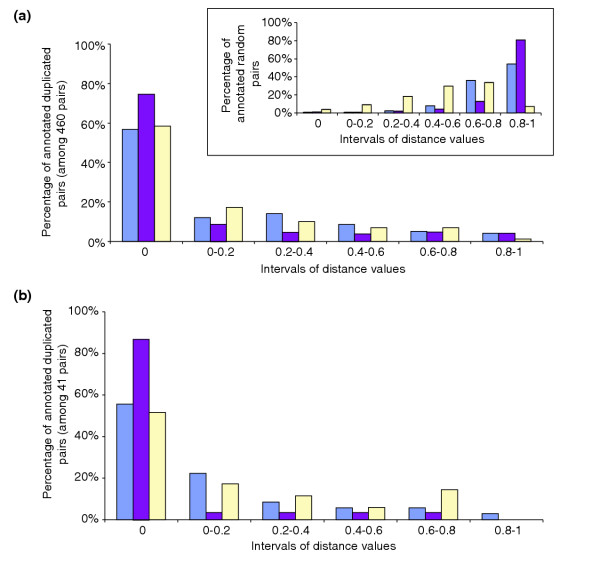
Distribution of functional distances between duplicated pairs based on Gene Ontology annotations. The annnotations are for 'Biological Process' (blue), 'Molecular Function' (purple) and 'Cellular Component' (light yellow). Distributions of distances (ranging from 0 to 1) based on annotations for (a) the 460 duplicated pairs, (a, inset) randomly selected pairs and (b) the 41 duplicated pairs present in the PRODISTIN tree.